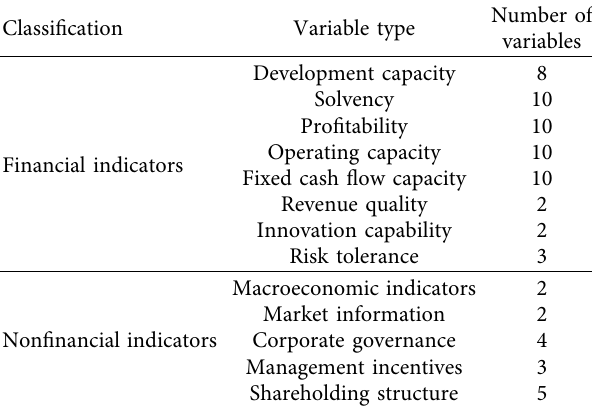
Table 2: Description of model characteristics